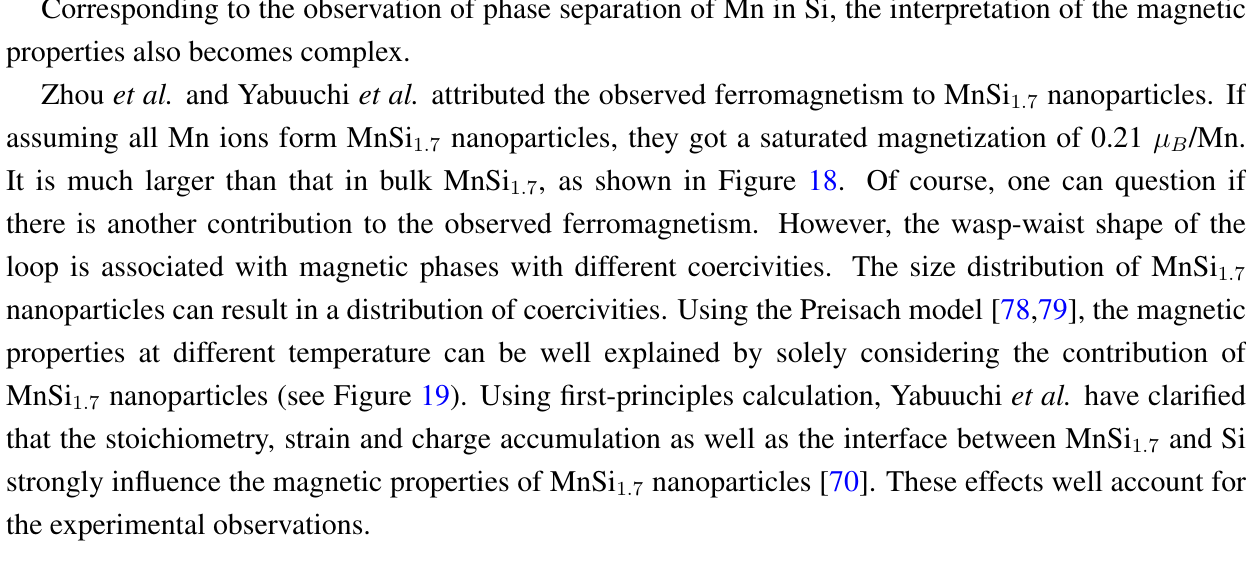
Figure 18 . Magnetic properties of Mn implanted Si measured at 10 and 100 K. The saturation magnetization of MnSi is indicated by lines for comparison. (Reprinted with 1 . 7 permission from Ref. [68]. Copyright 2007 by the American Physical